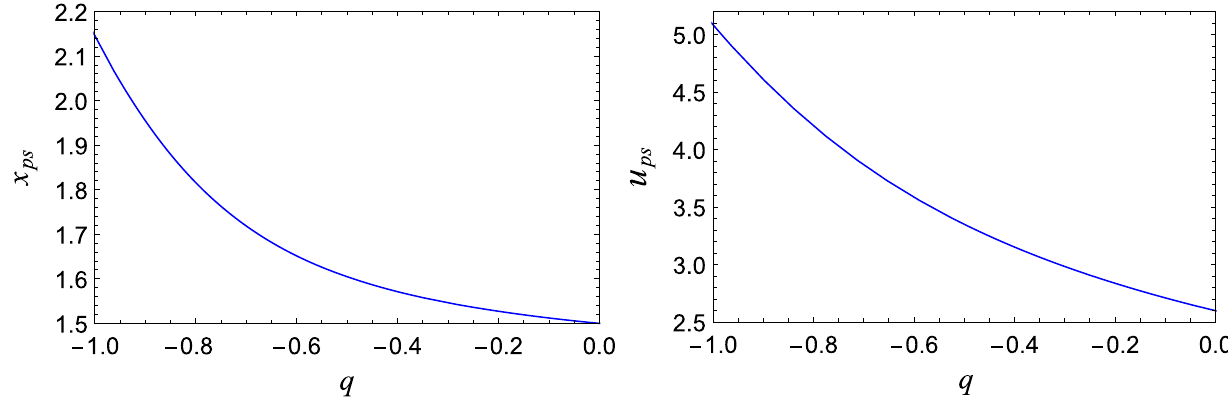
Fig. 4 The behavior of the photon sphere radius x ps (left) and the critical impact parameter u ps (right) as a function of the hair parameter q . As q → 0, the values x ps → 1 . 5 and u ps → 2 . 598 correspond to the Schwarzschild black hole